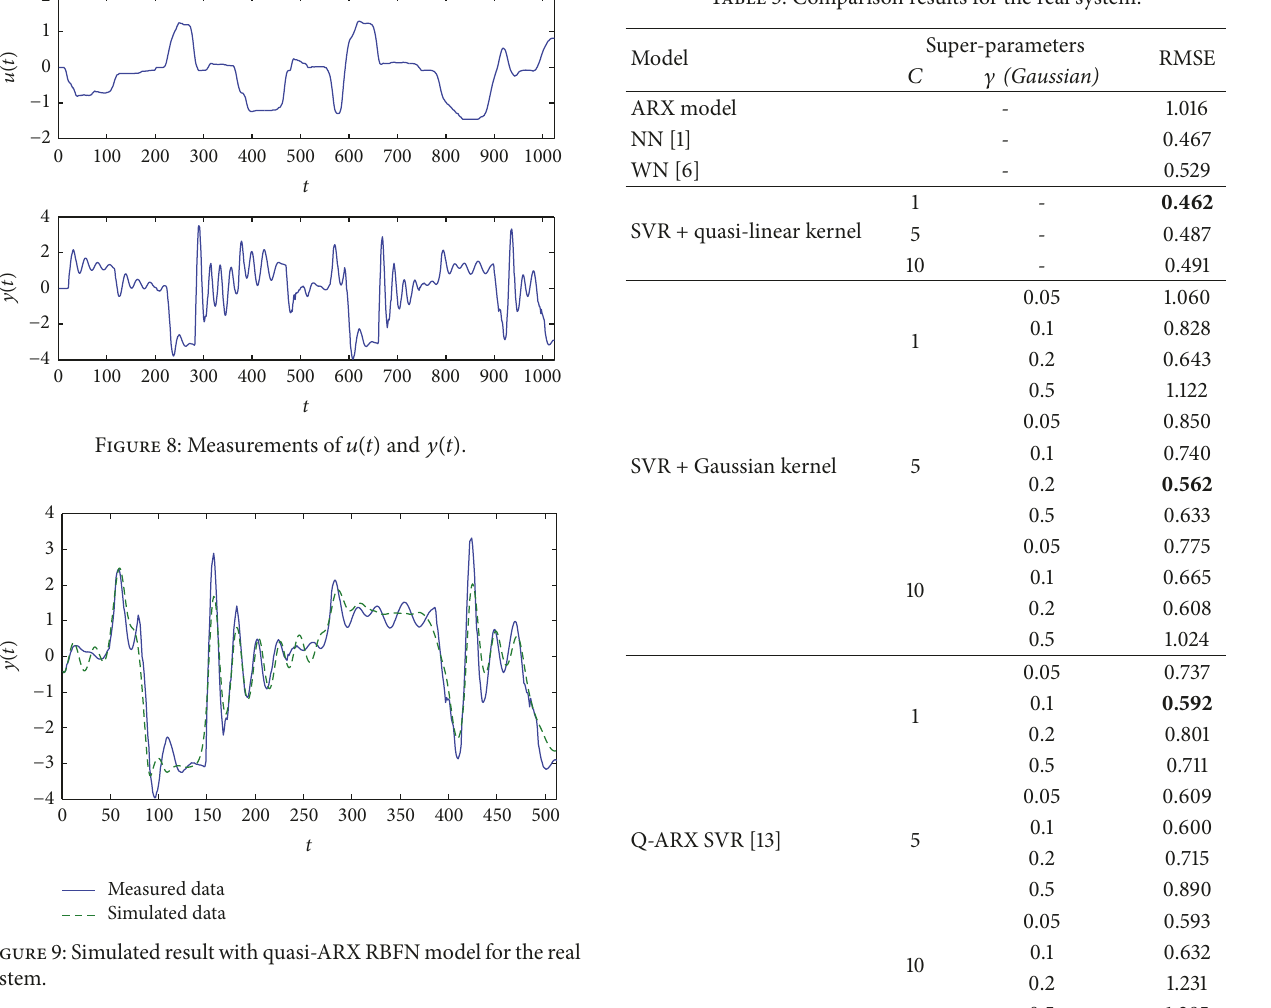
Table 3: Comparison results for the real